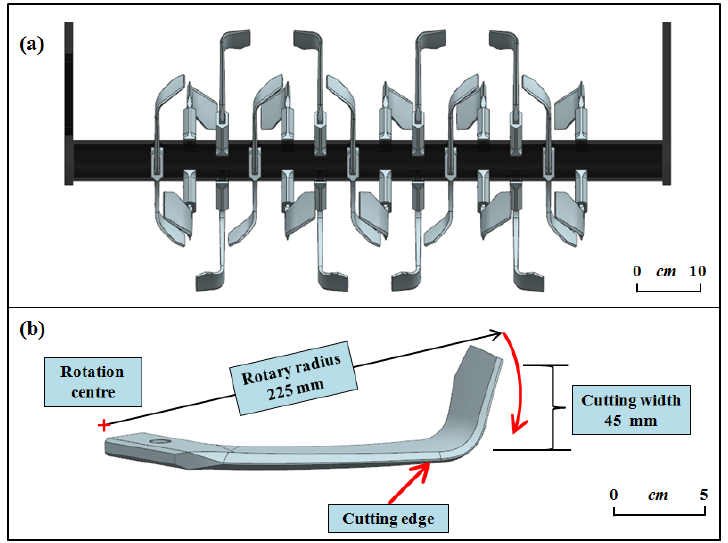
Figure 2. Rotary tillage tools ( a ) the cutter shaft, ( b ) the rotary blade.